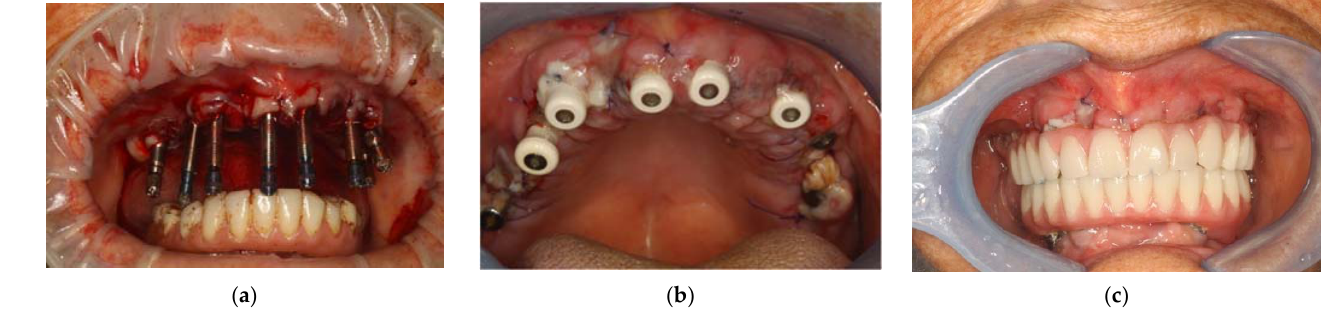
Figure 7. Transfer on implants to make the impression ( a ); healing caps on implants ( b ); prosthesis with immediate loading after 48 h ( c ).